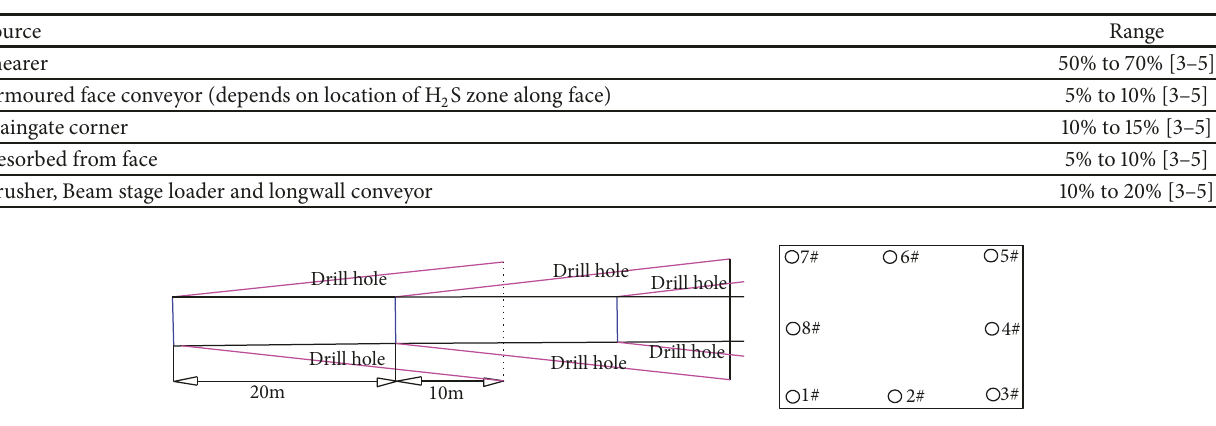
Figure 6: Profile chart of alkali injection hole and alkali injection excavation process drawing in heading face.